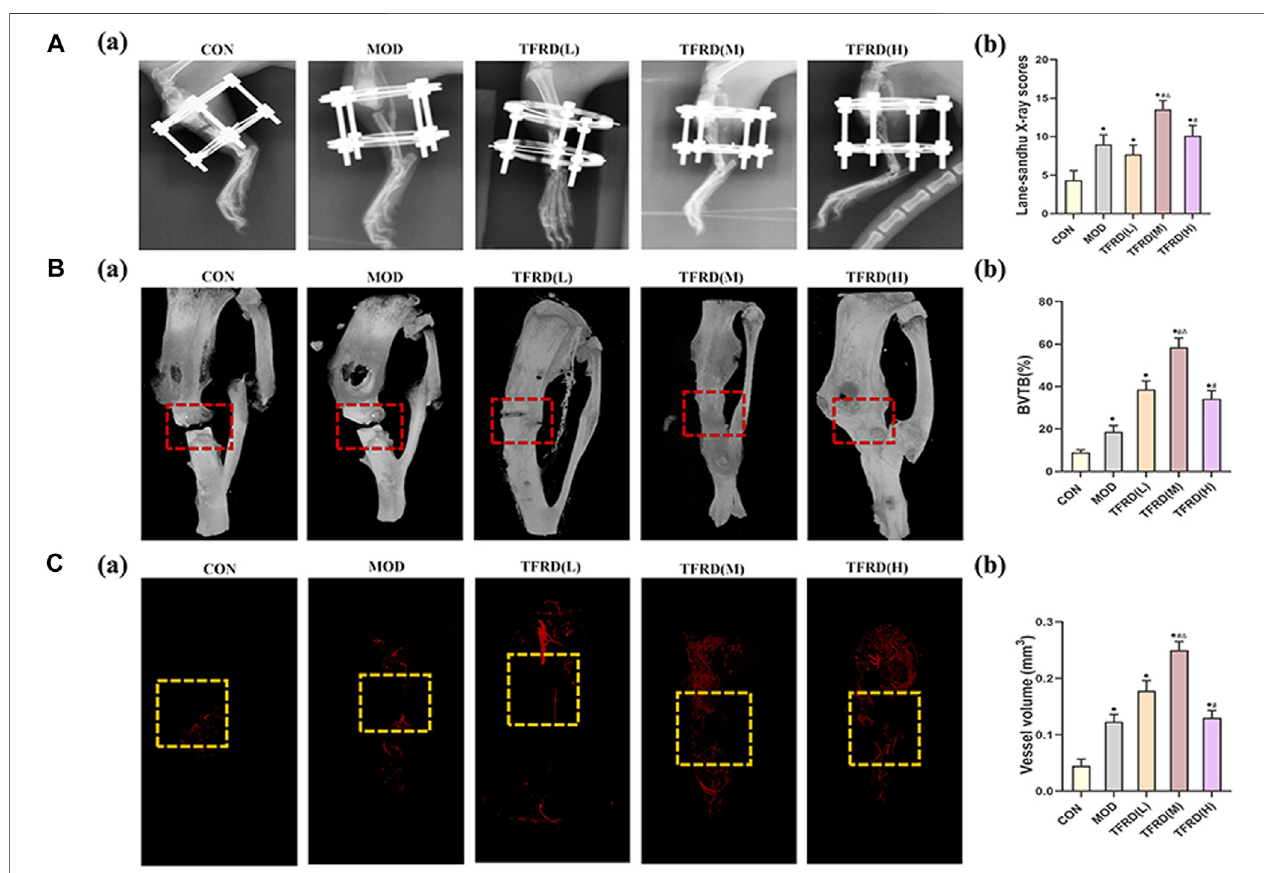
FIGURE 3 | Evaluation of radiological, micro-CT images, angiogenesis of tibial bone repair of fi ve groups (A) . Radiological evaluation of bone repair (A) (a). Representative radiographs of bone repair of the fi ve groups at 12 weeks after surgery ( n (cid:1) 3 per group); (A) (b). Quantitative analysis of radiographic scores (B) . Representativemicro-CTimagesofbonerepair (B) (a).Three-dimensionalreconstructedimagesofbonedefectsat12 weeksaftersurgicaldottedboxesindicateregion of interest (ROI), representing bone distracted gaps ( n (cid:1) 3 per group); (B) (b). Quanti fi cation of bone tissue volume/total tissue volume and (BV/TV) insides bone distracted regions (C) . Evaluation of angiogenesis within the distracted gaps at 4 weeks after surgery (C) (a). Representative angiographs of the distracted gaps in the fi vegroups( n (cid:1) 3pergroup) (C) (b).Quanti fi cationofvesselvolumewithinthedistractedregions(yellowdottedboxesindicateregionofinterest(ROI),representingbone distracted gaps). The dataare expressed asthe mean ± SEMof three independent experiments. * p < 0.05, compared with the control group; # p < 0.05, compared with the model group; Δ p < 0.05, compared the difference of the medium dose with the low and high doses in the TFDR